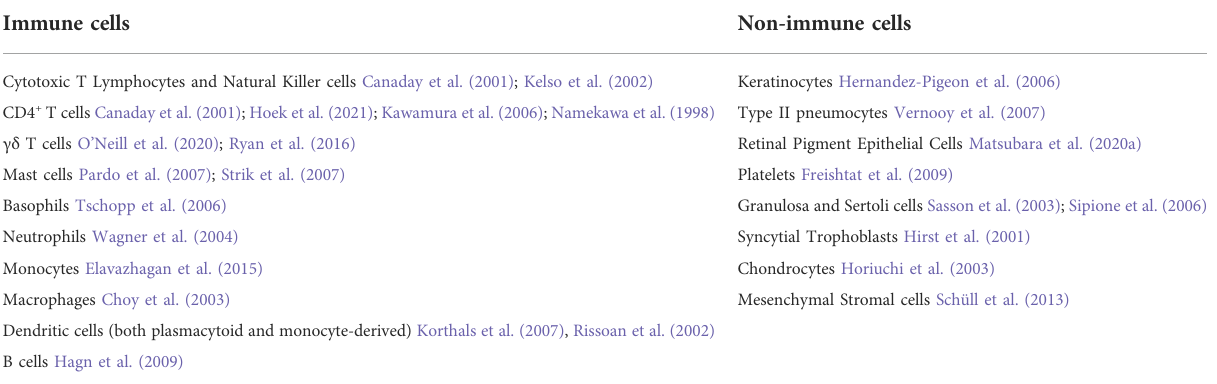
Table of cell types validated to express granzyme